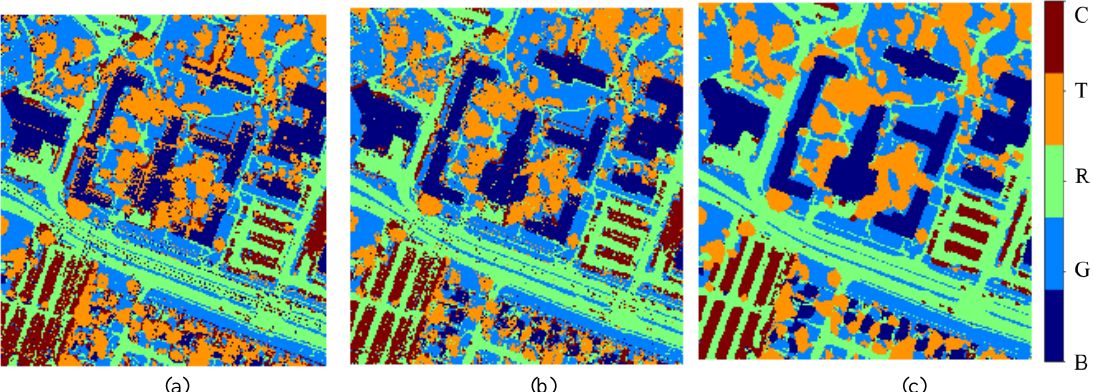
Figure 4. The resulted classification maps using LiDAR data and VHR imagery (a) The RBF-SVM classifier using low-level features; (b) The MLP classifier using low-level feature; (c) The proposed CNN-based framework.